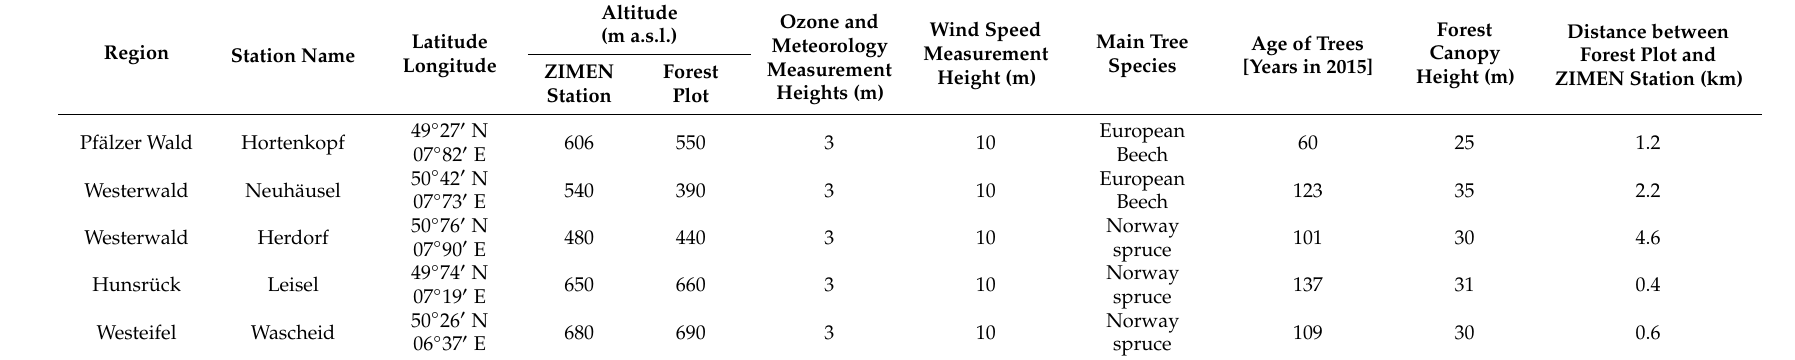
Table 1. The main characteristics of ZIMEN stations and their neighboring ICP Forest Level II forest plots.